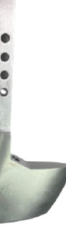
Figure 10. Su 3 entity. Table 6. Soil